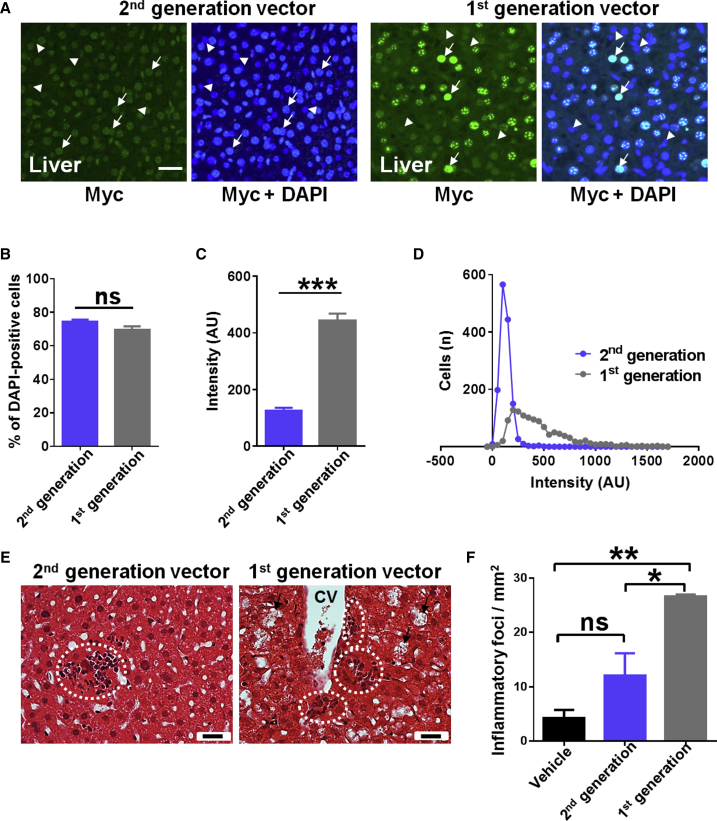
Reduced Expression of Vector-Derived MeCP2 in the Livers of Mice Treated with Second-Generation Vector(A) Flattened confocal stack images from livers of mice 1 month after being injected intravenously at 5 weeks of age with the second-generation vector or first-generation vector at 1 × 1012 vg per mouse; confocal settings were the same in each case. Tissues were immunolabeled with anti-Myc and DAPI nuclear stain. Arrows indicate transduced cells (Myc-positive), and arrowheads indicate non-transduced cells. (B) Transduction efficiencies in the liver for both vectors. (C) Quantification of cellular levels of vector-derived MeCP2 measured as anti-Myc immunofluorescence in transduced cells in the liver (n = 3 mice, 1,400 transduced cells). Data are presented as mean ± SEM. (D) Frequency distribution of cellular levels of vector-derived MeCP2 in the liver, measured as in (C). (E) Liver sections stained with H&E showing vacuolation of hepatocytes (arrows) and sites of mononuclear cell infiltration (dashed circles). CV, central vein. White scale bar indicates 20 μm. (F) Quantification of density of inflammatory foci in the livers of treated mice (n = 3 per group). Data are presented as mean ± SEM. *p < 0.05; **p < 0.01; ***p < 0.001; ns, not significant.